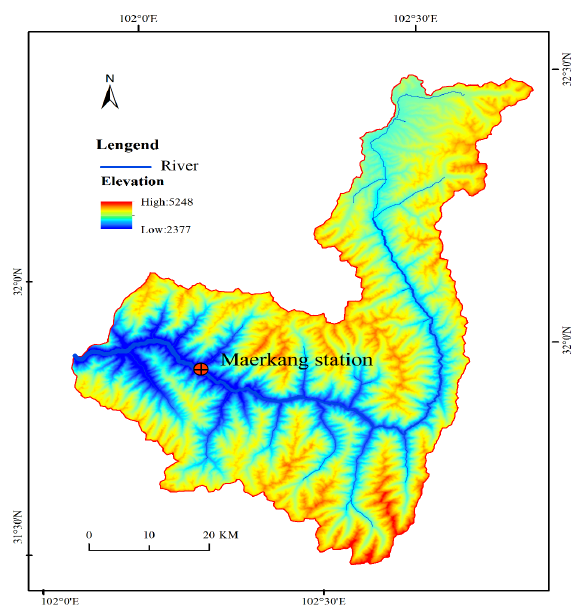
Figure 1. Sketch map of Suomo river basin